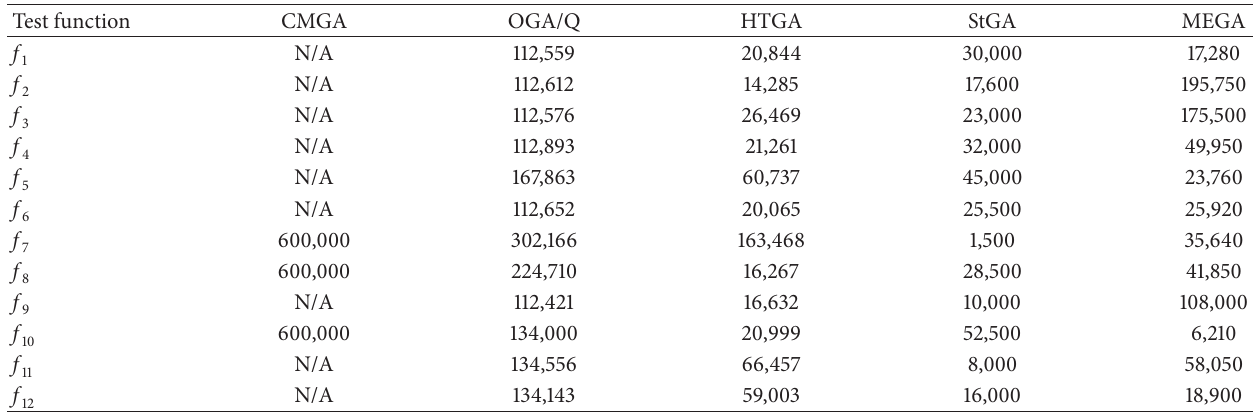
Table 6: Comparison of the computational effort (MNFE) with other